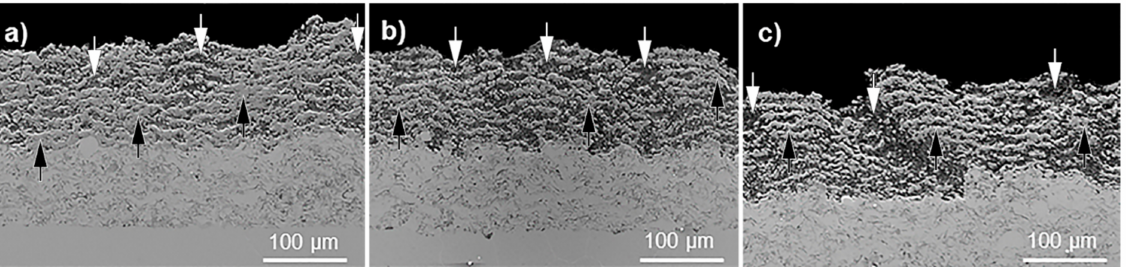
Figure 2. Cross-section micrographs of different SPS coatings: ( a ) Al 2 O 3 /TZ-3YS; ( b ) SiC-reinforced Al 2 O 3 /TZ-3YS; ( c ) SiC-reinforced Al 2 O 3 /TZ-3YS with fructose. The different zones of the coating are marked with arrows: white arrows indicate unmolten/resolidified zones, and black arrows indicate fused